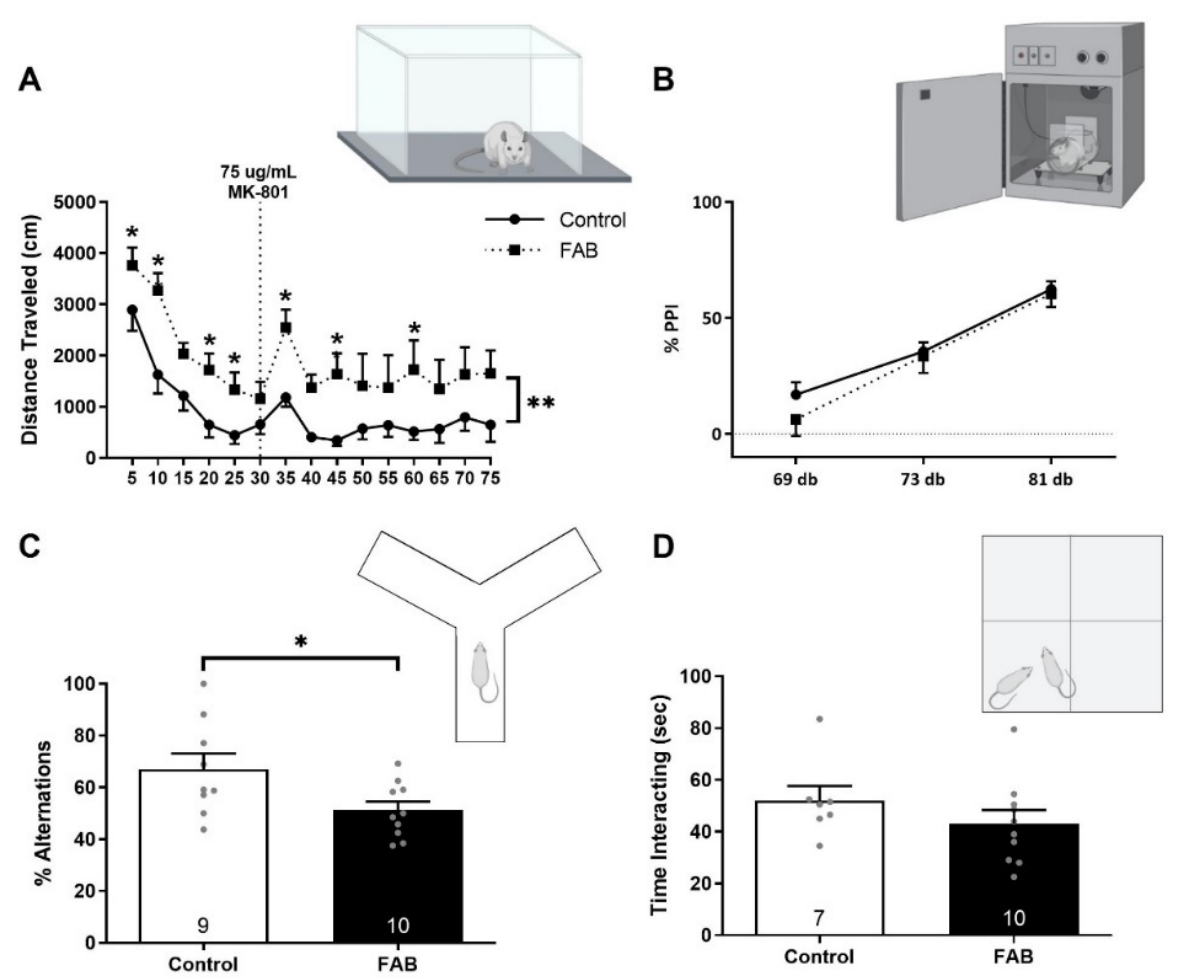
Figure 3. FAB rats displayed a baseline locomotor activity level higher than that of controls, which persisted after systemic MK-801 administration ( A ). No differences were observed in pre-pulse inhibition of startle (PPI) ( B ). A significant decrease in the percentage of spontaneous alternations in the Y-maze was observed in FAB rats ( C ). No differences were observed in the time spent interacting socially ( D ). * p = 0.033. ** denotes a main effect of strain p < 0.001. The icons used were adapted from BioRender.com (2021), retrieved from https://app.biorender.com/illustrations (accessed on 18 August 2021).